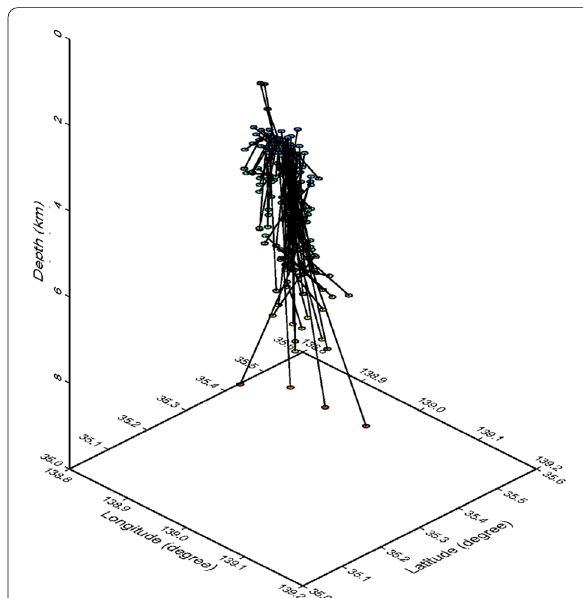
Fig. 6 Three-dimensional plot for differences of hypocentral parameters between those determined by the Hot Spring Research Institute and determined by the proposed